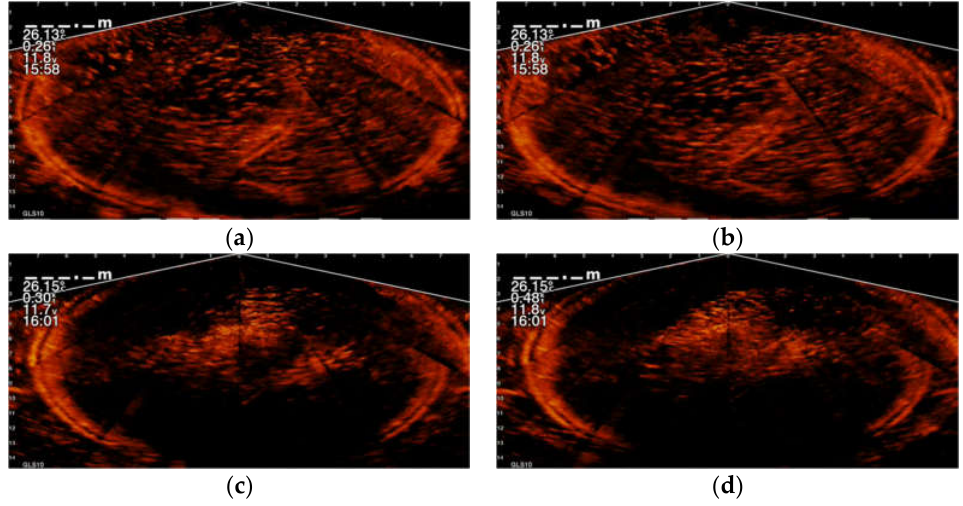
Figure 14. Sonar images of a fish school in an off-shore net cage, where (a) and (b) show the fish dispersing; and (c) and (d) show fish swimming toward the water surface to grab feed pellets.